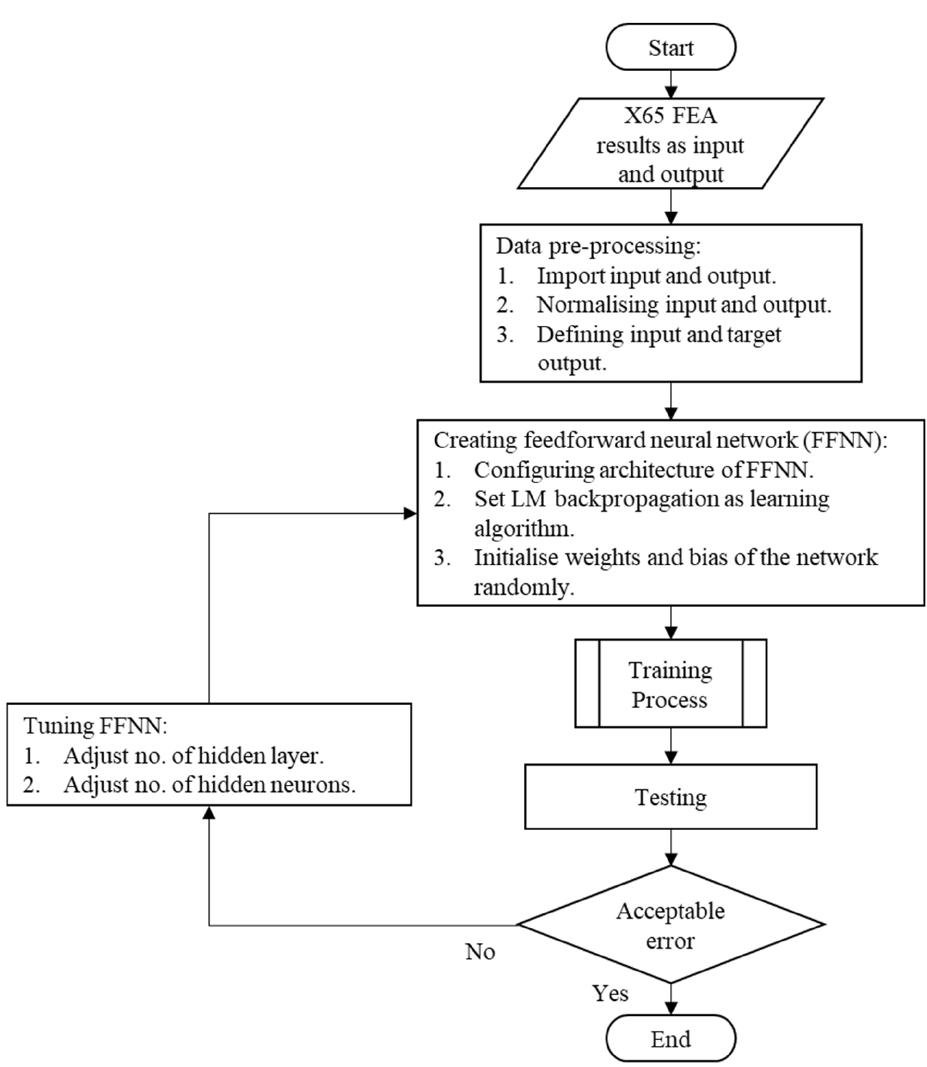
Figure 7. ANN development flowchart.